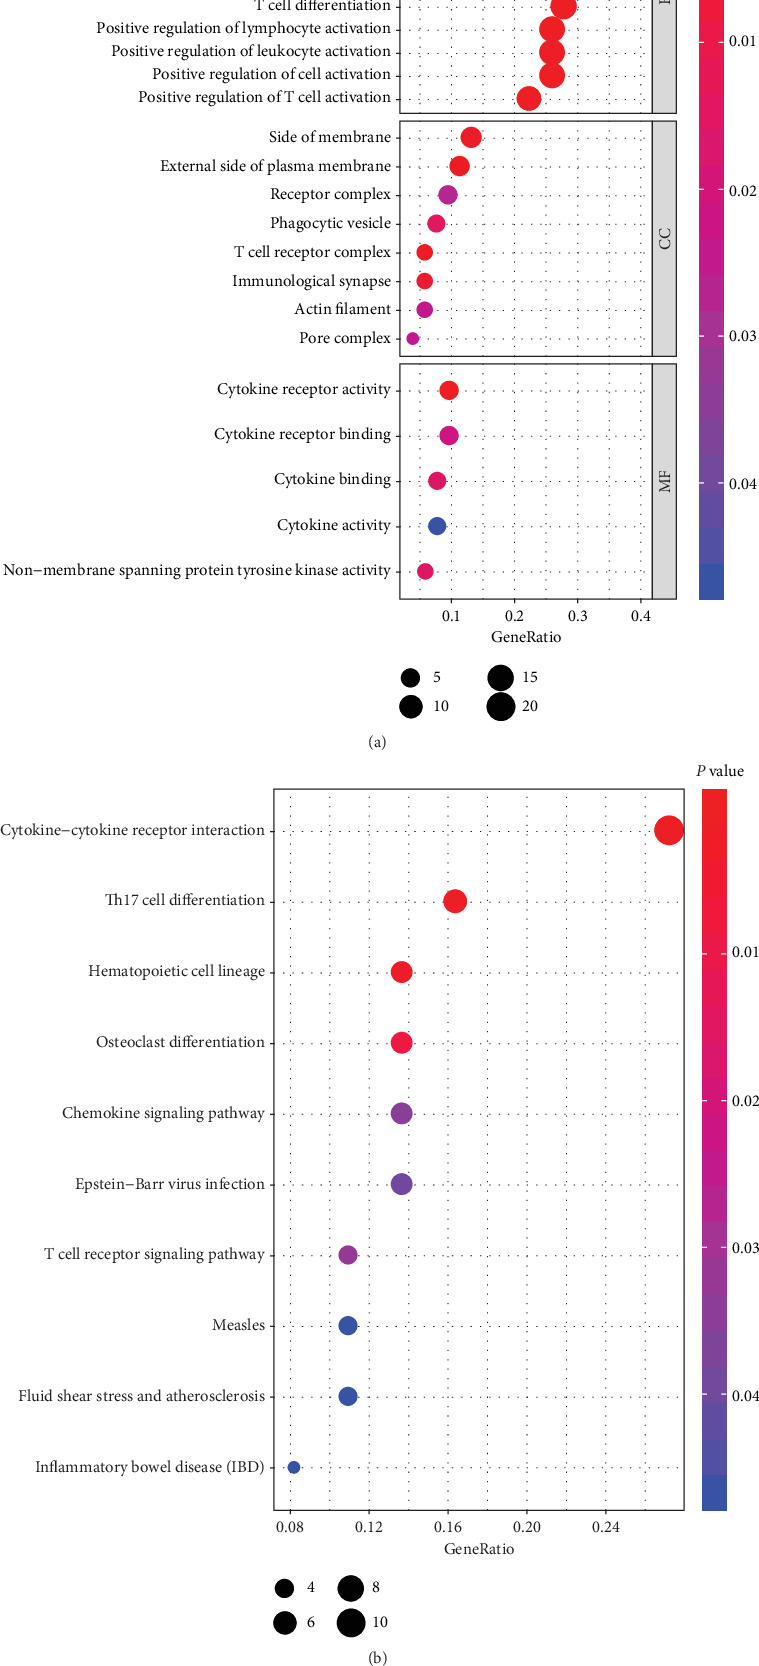
Functional enrichment analysis results of immune genes. (a) GO term enrichment results. (b) KEGG pathway analysis.